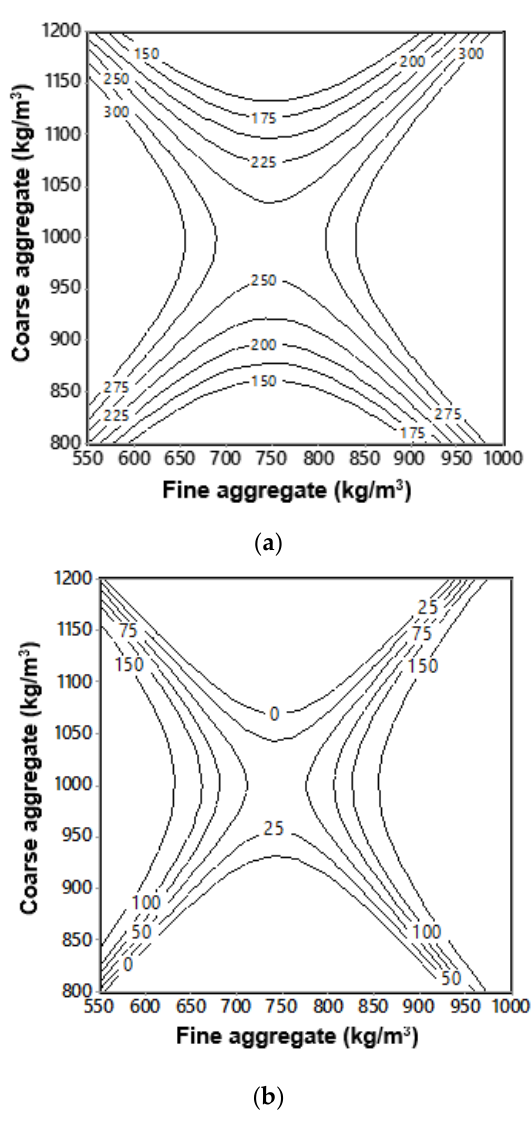
Figure 5. Isoresponse contours for slump (mm) ( a ) without fiber content; ( b ) with fiber content.